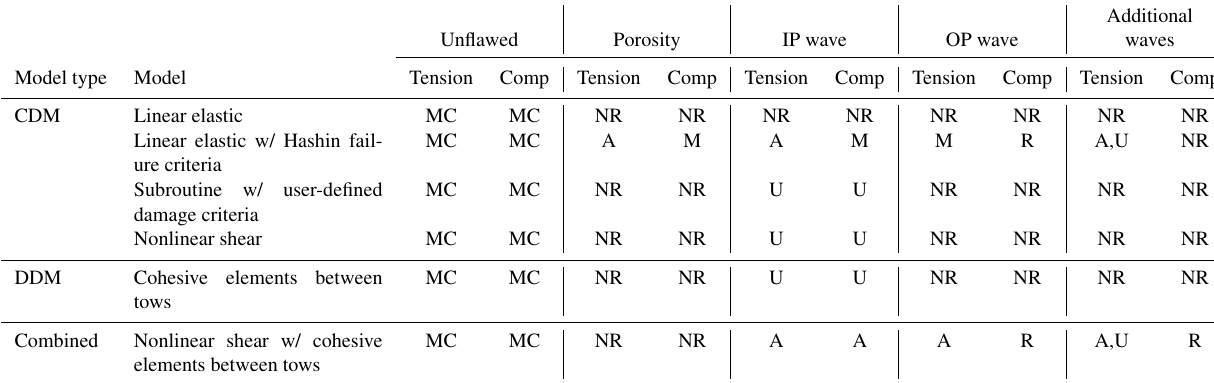
Table 5. Summary of results of each model for acceptability.